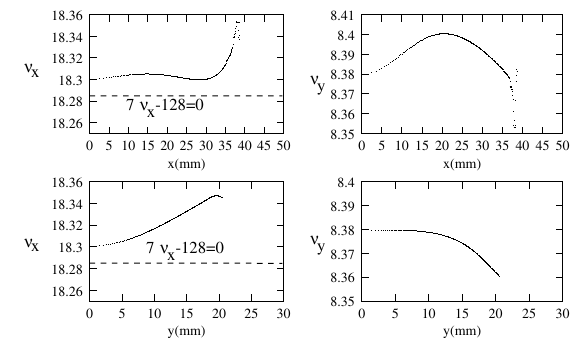
FIG. 7. Tune shifts with amplitude for the second optics of SOLEIL. For each case the fixed coordinate x or y is set to 1 (cid:1) m . By using the harmonic sextupoles, the resonance of orders 7 and 9 are avoided (compare with Fig.